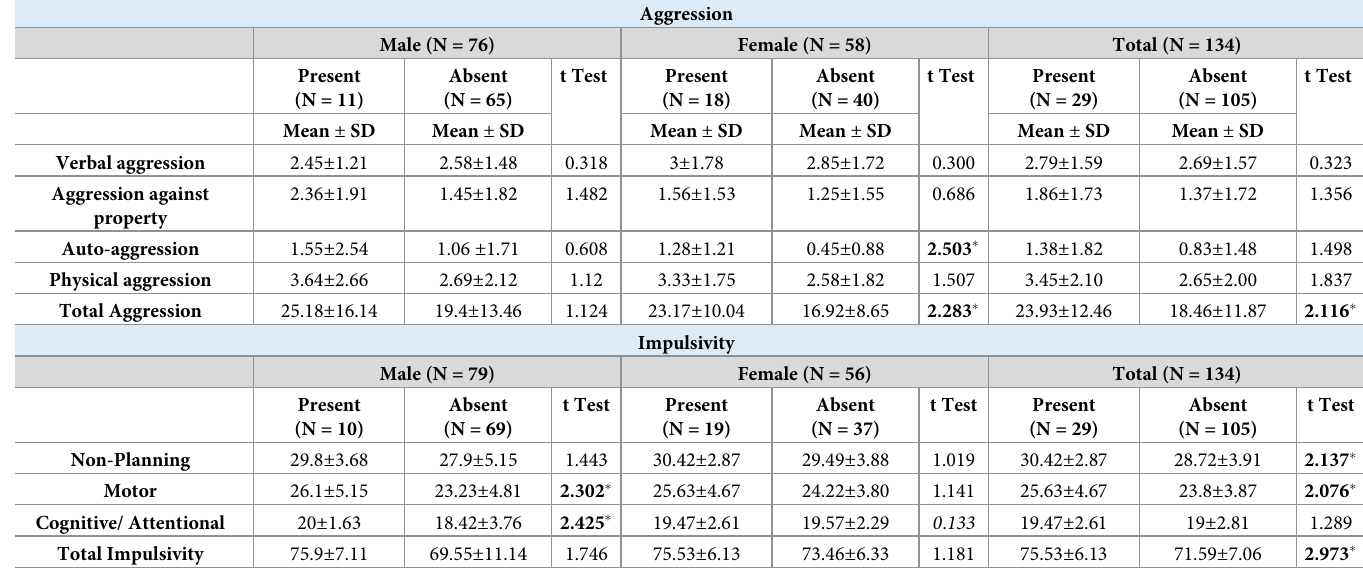
Table 2. Status of aggression and impulsivity among Idu Mishmi suicide attempters in males and females (Univariate t Test